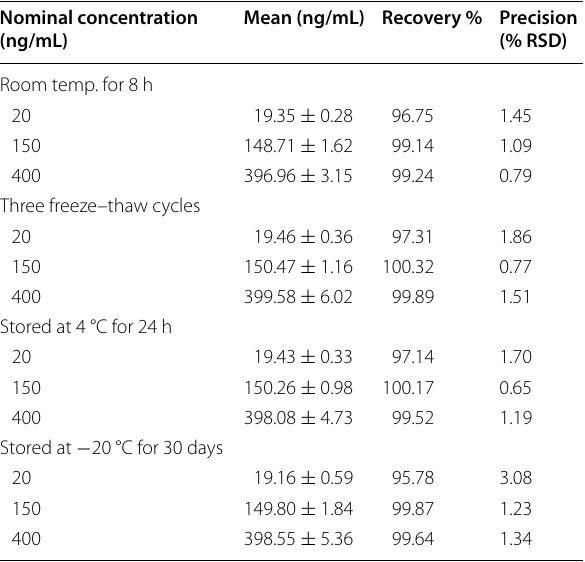
Table 5 VNT stability data in RLMs matrix under different conditions